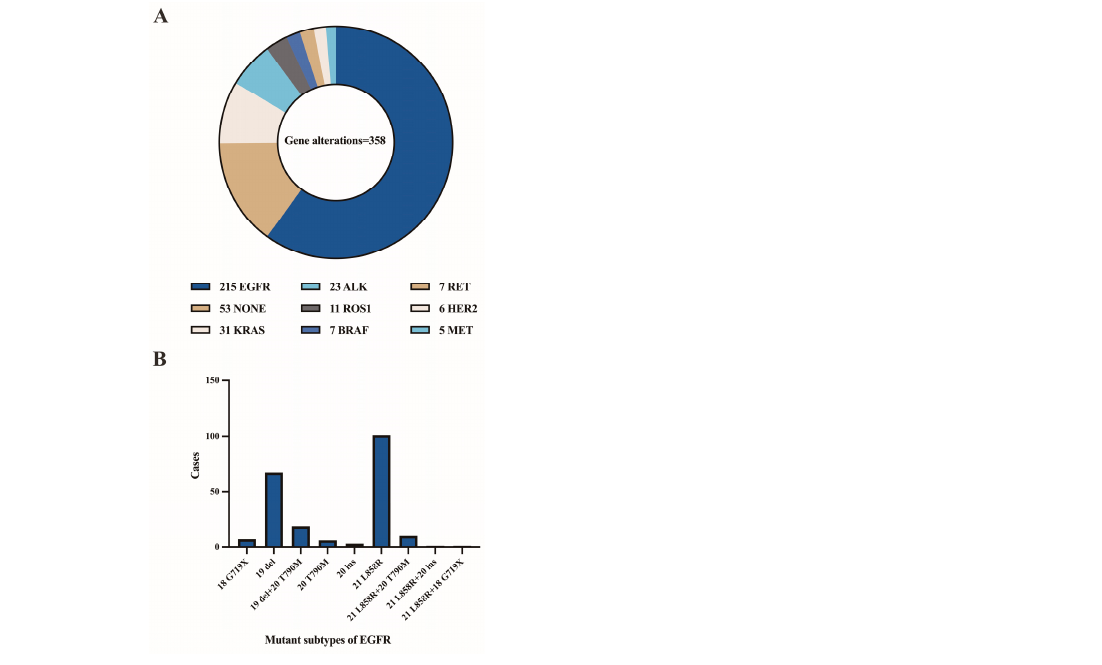
Figure 5. ( A ) The specific types of gene alterations. ( B ) Number of mutant subtypes of EGFR.